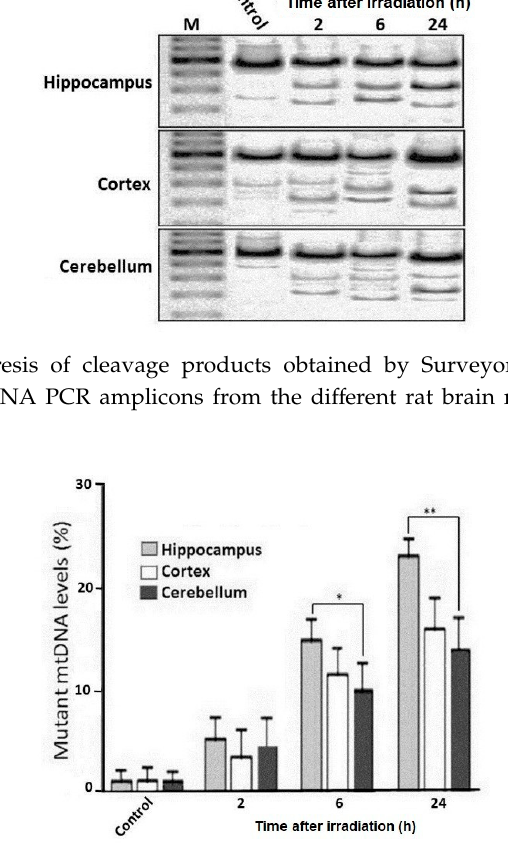
Figure 4. Percentage of Surveyor nuclease cleaved heteroduplexes of PCR amplicons of mtDNA (507 bp) from the different rat brain regions at 2, 6, and 24 h after irradiation. The data are presented as mean ± SD from 4–5 independent experiments. Statistical significance was set at * p < 0.05, ** p < 0.01.